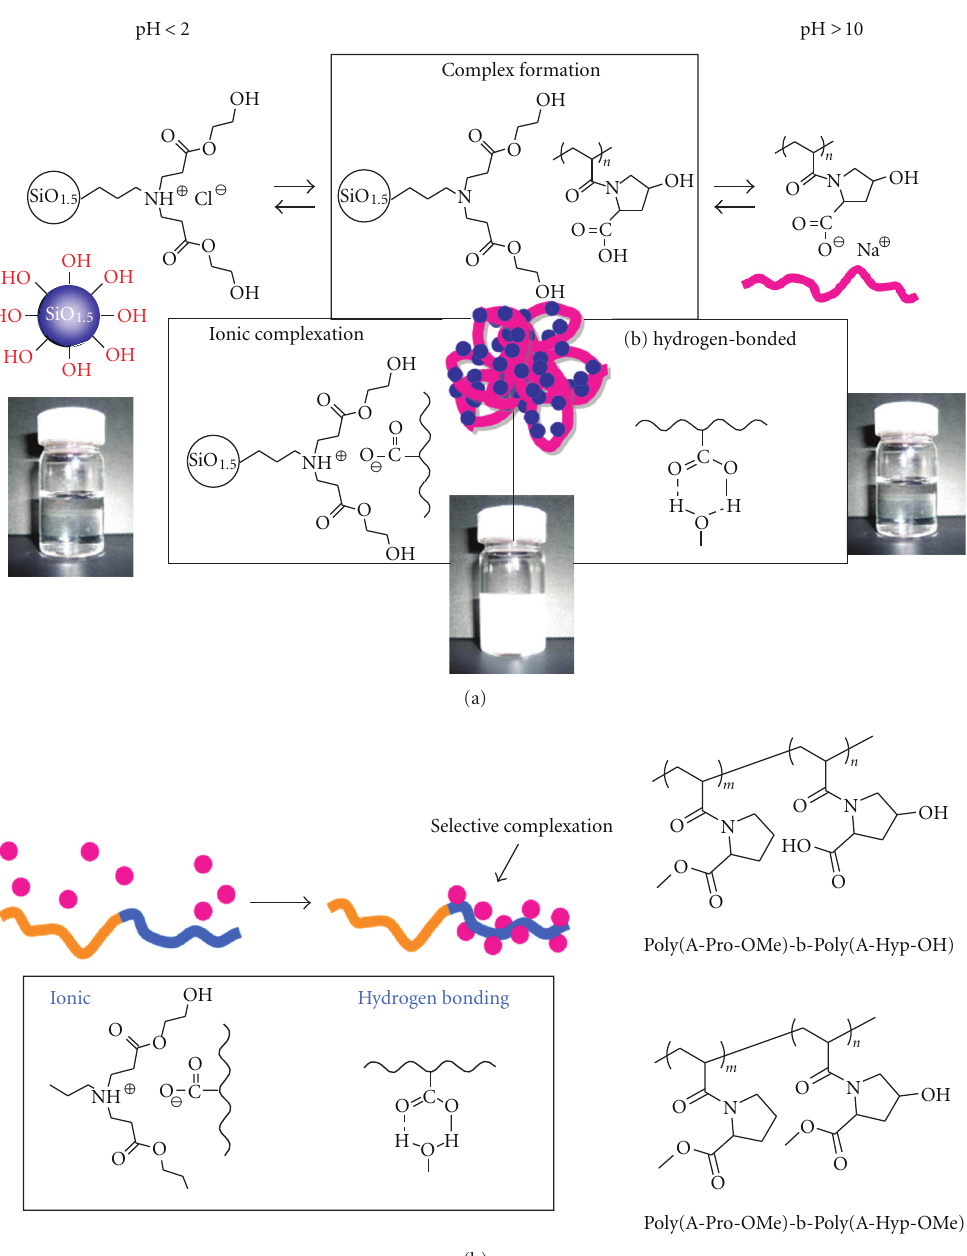
Figure 11: Smart organic-inorganic hybrids based on (a) complexation of amino acid-based polymer and water-soluble silsesquioxane nanoparticles, and (b) selective complexation of the silsesquioxane nanoparticles and block